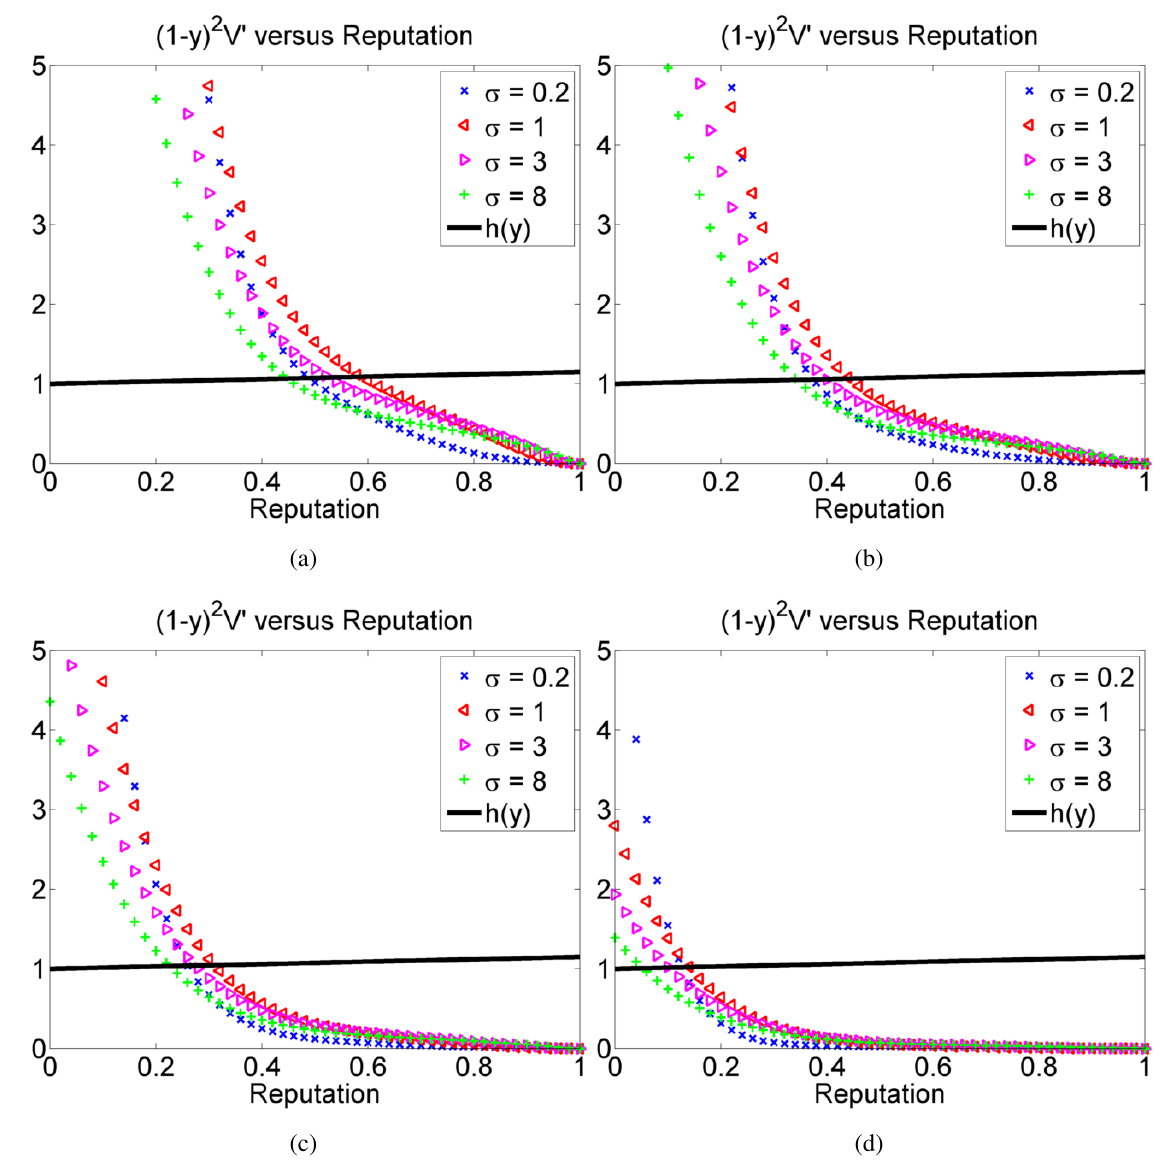
Figure 4. A plot of the quantity (1 − y ) 2 V (cid:48) , where V is a numerical solution of the the full boundary value problem Equation (14). The value y ∗ is defined as the intersection of these curves with h ( y ) (black solid line). ( a ) ρ = 0 . 1 ; ( b ) ρ = 0 . 2 ; ( c ) ρ = 0 . 5 ; ( d ) ρ = 2 . 0